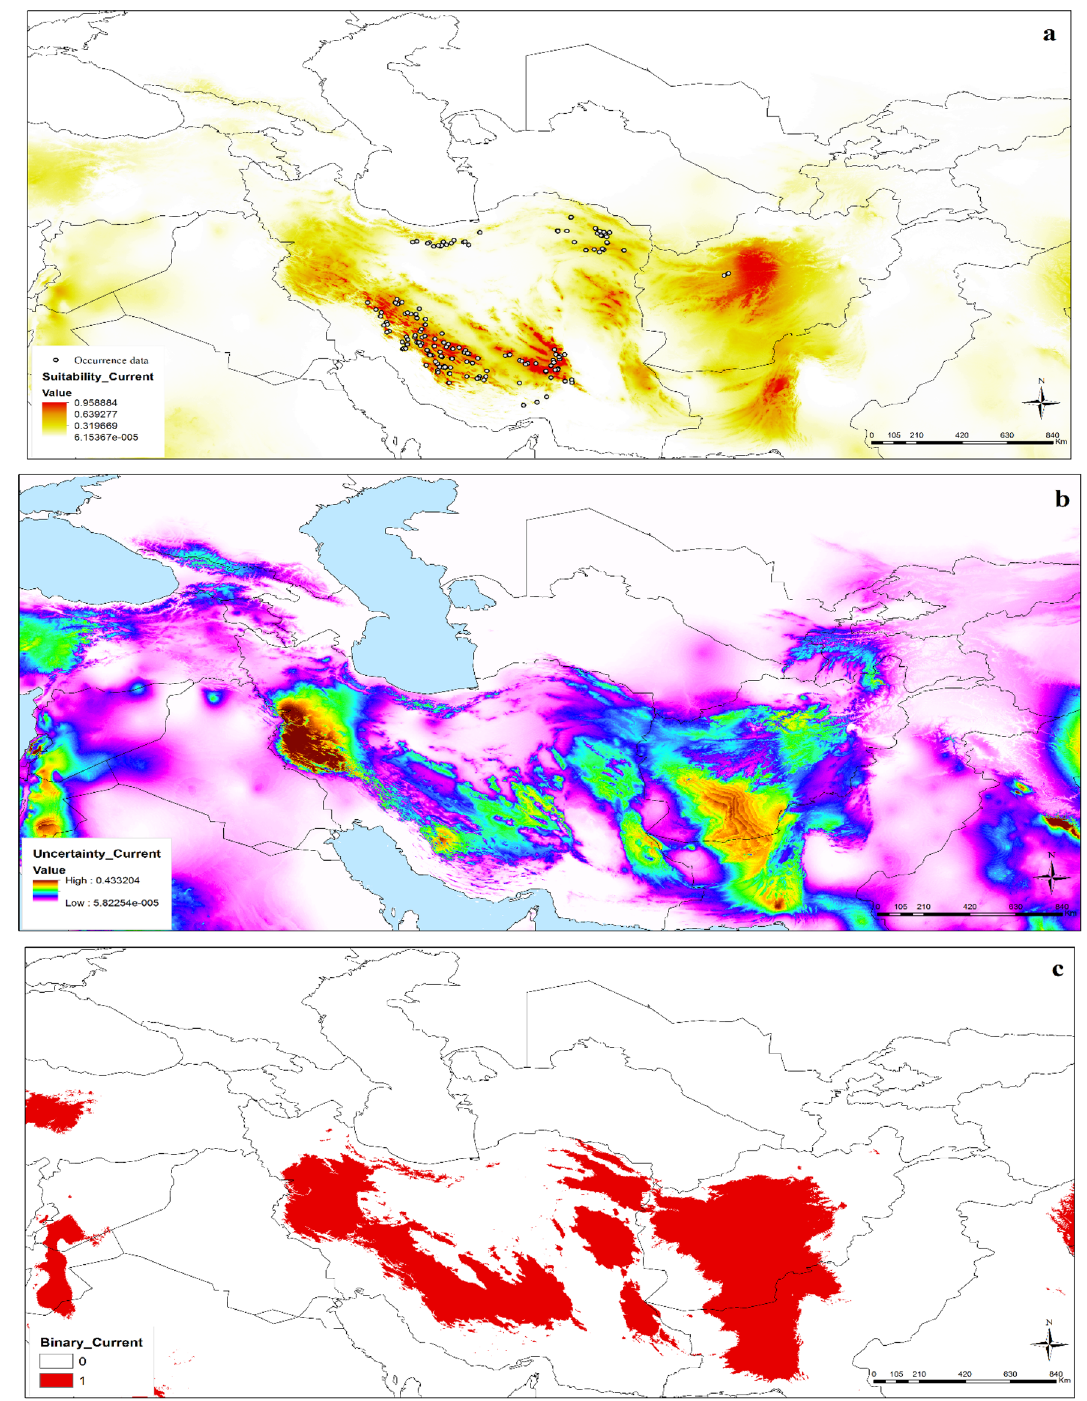
Figure 3. Predicted currently suitable regions for Nepeta glomerulosa across the southwestern and central Asia: ( a ) median prediction (based on median values in the replicates of the final model for current conditions), ( b ) uncertainty map (range through 10 cross–validation replicates), and ( c ) binary map (based on suitability scores and maxSSS threshold) (ArcGIS version 10.3.1; http:// www. esri.